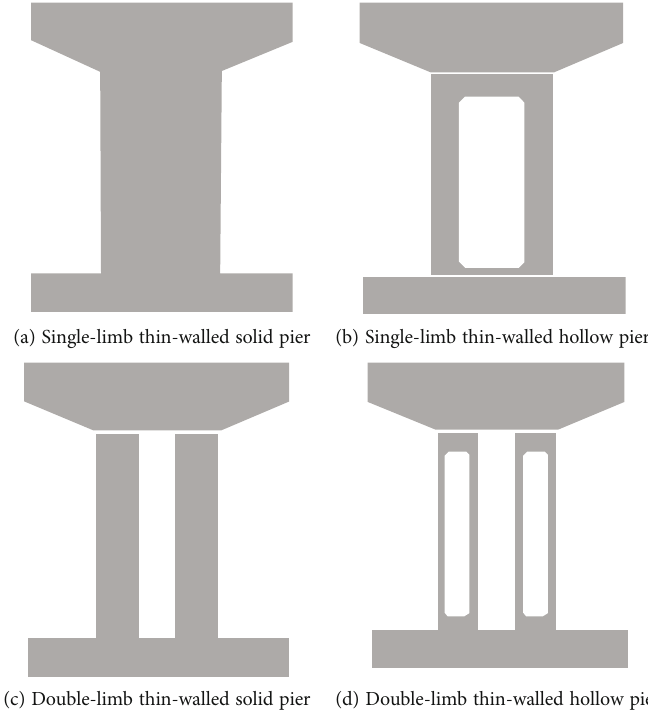
Figure 5: Cross sections of di ff erent piers of continuous rigid-frame bridges.